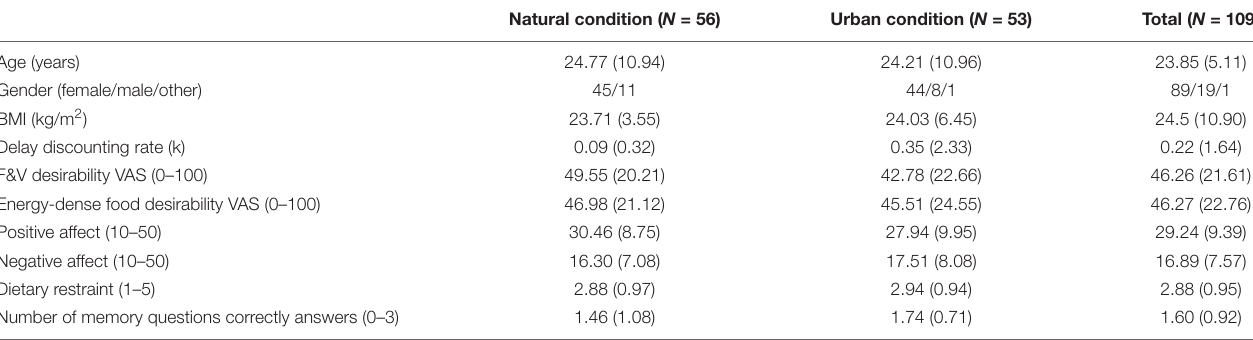
TABLE 2 | Participant characteristics and descriptives for main variables stratified by image exposure condition. Values are mean with SDs in parentheses unless stated otherwise.